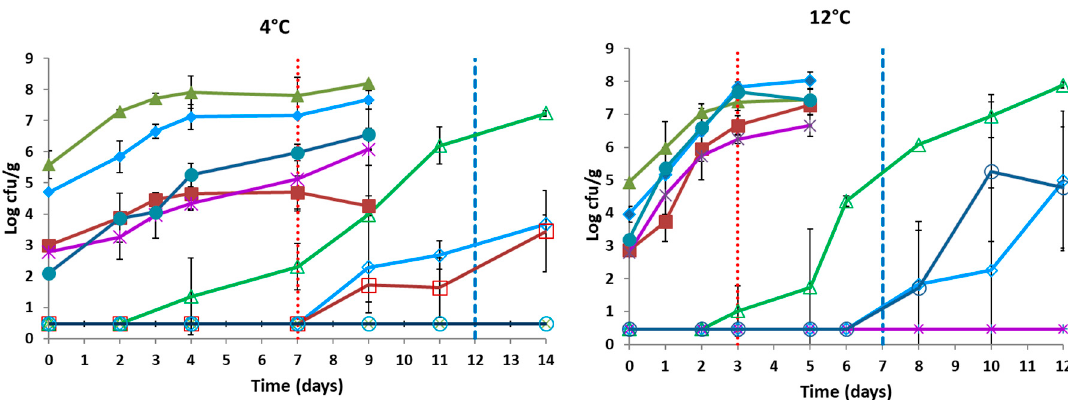
Figure 1. Growth curves of B. thermosphacta ( ▲ ) or ( △ ), Pseudomonas spp. ( ♦ ) or ( ◊ ), LAB (*) or (x), Enterobacteriaceae ( ● ) or ( ○ ) , yeasts/molds ( ■ ) or ( □ ), on untreated (closed symbols), or HPP-treated (500 MPa / 10 min) (open symbols) chicken fillets, respectively, during storage under vacuum package at 4 °C (left) and at 12 °C (right). Vertical red dotted line: end of the control samples shelf-life according to sensory analysis. Vertical blue dashed line: end of the HPP-treated samples shelf-life according to sensory analysis. Error bars represent the mean values ± standard deviation.